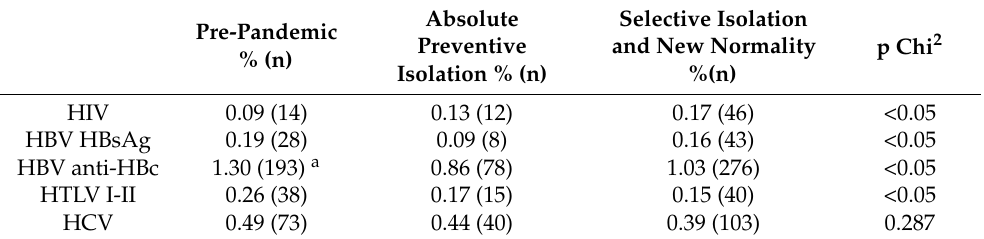
Table 2. Seroprevalence of viral infections detected in the blood bank in the three study groups.